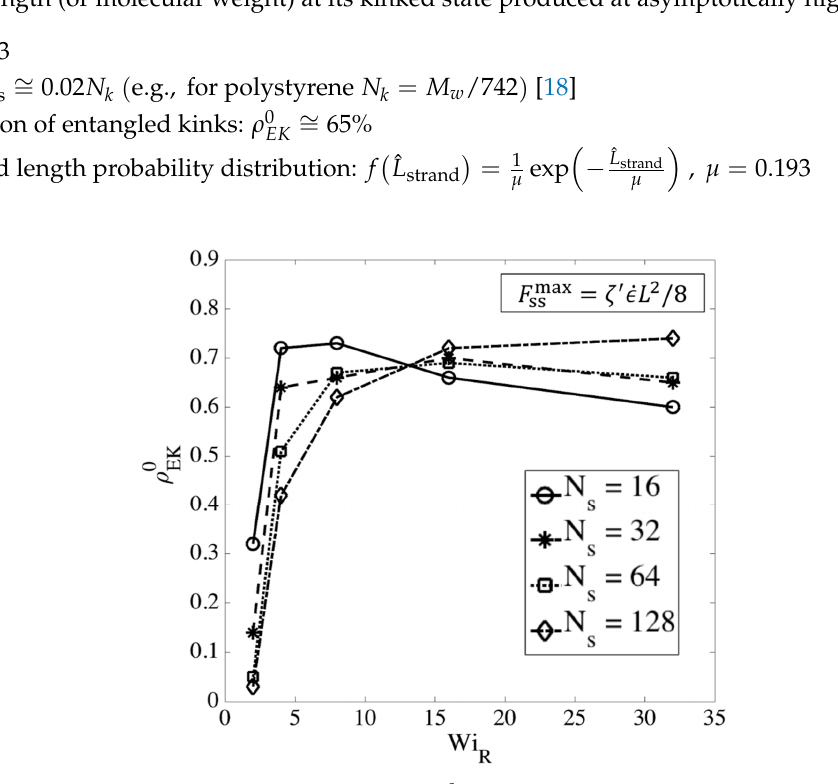
Figure 15. Fraction of entangled to total kinks ( ρ 0 ) for different chain lengths as a function of Weissenberg number at the transition to the kinked state.